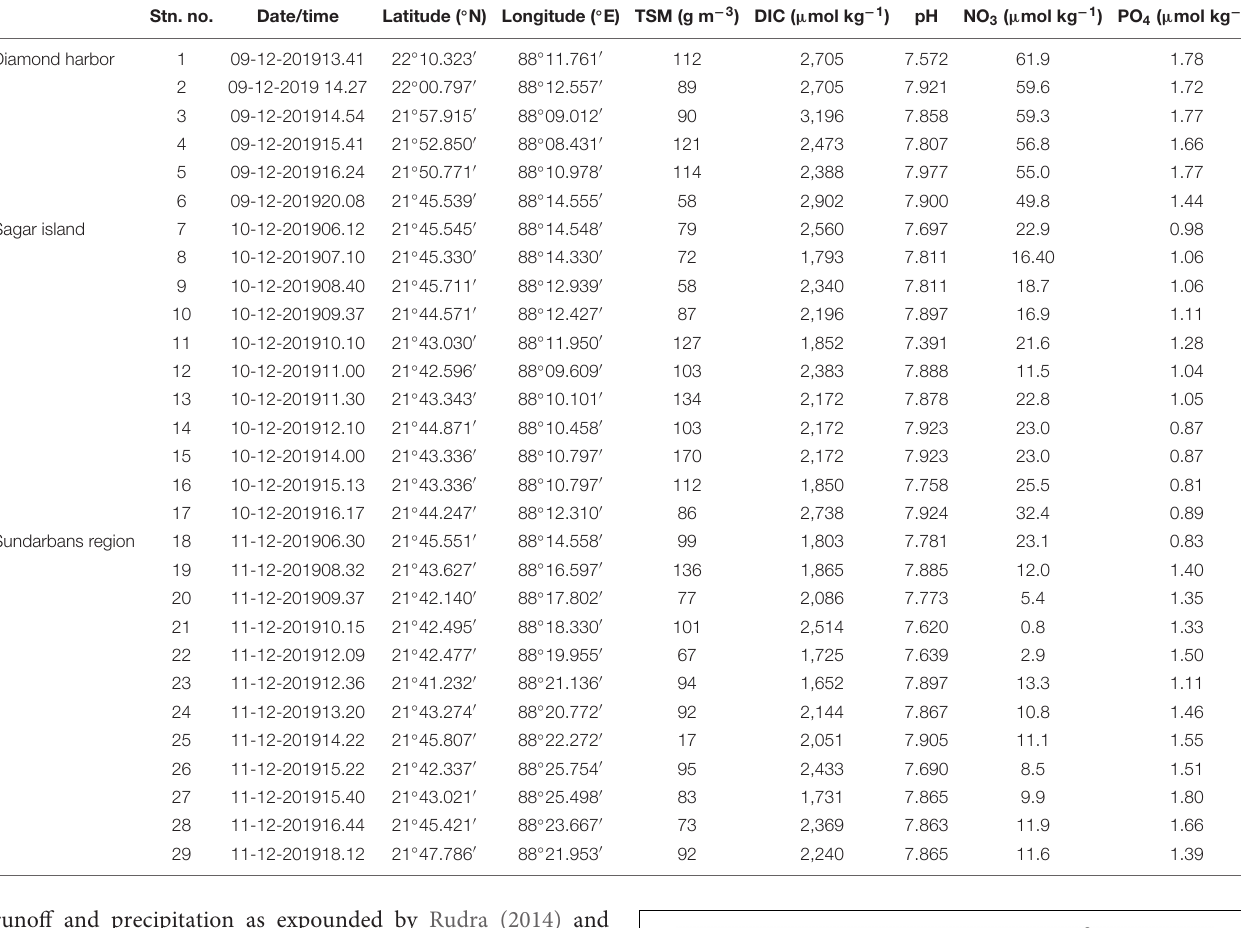
TABLE 2 | Biogeochemical properties of surface waters along the salinity gradient of the estuary during December 2019 (north–east monsoon). Stn. no.